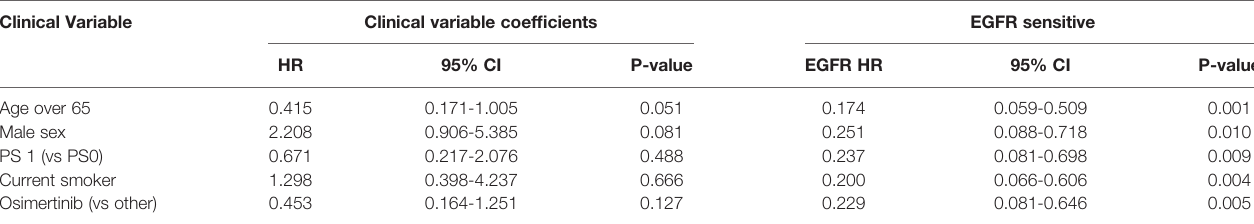
TABLE 2A | Bivariable PFS.